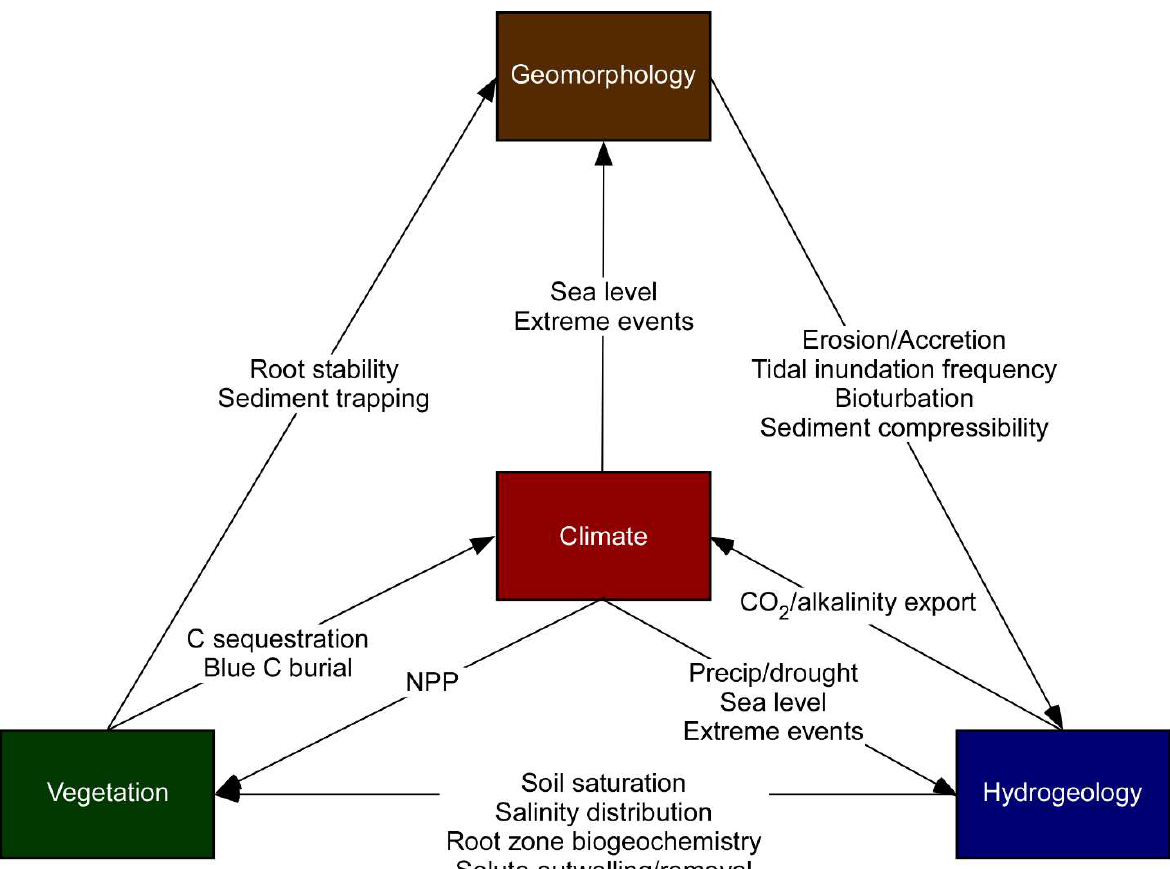
Figure 8. Generalized relationship of salt marsh ecosystem components including climate, geomorphology, hydrogeology and vegetation zonation. Note that human activities may impact each of these components with potential feedbacks outlined in the diagram. NPP = Net Primary Production; Precip = precipitation.